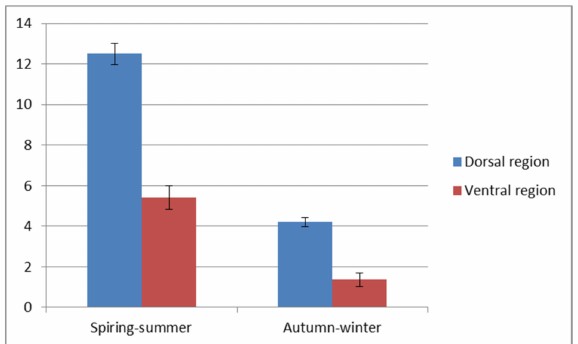
Figure 4. Number of epithelial layers in the fish skin.